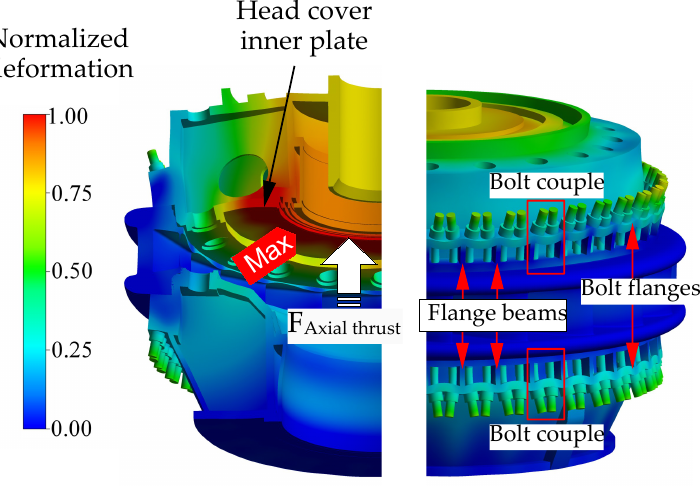
Figure 14. Deformation distribution of the stationary structures in section view. The vibration behavior of the head-cover and head-cover bolts during load rejection are strongly related to the axial thrust on the head-cover. Since the inner head-cover has no support in the axial direction, the maximum deformation of the structures appears at the inner plate of the head-cover lifted by the large axial thrust. During the load rejection process, the maximum deformation of the head-cover with time follows the variation of the axial thrust and reaches its maximum at t = 13.2 s (Figure